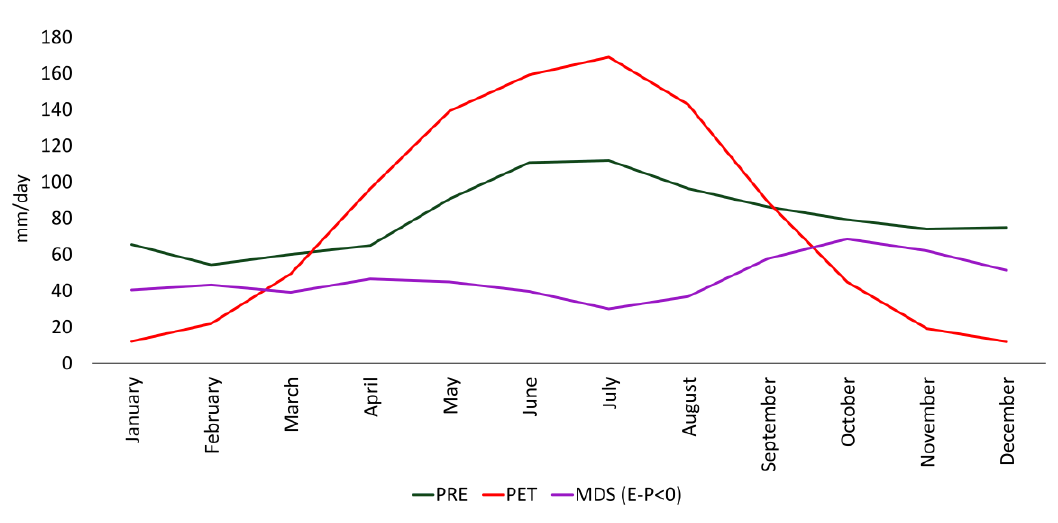
Figure 2. Climatological annual cycle of precipitation (PRE, ×10 green line), potential evapotranspiration (PET, ×10 red line) (data from the Climatic Research Unit (CRU) (TS3.24.01) (scale: mm/day) values integrated over the CEU), with the moisture contribution from the MDS (purple color (mm/day) values integrated over the CEU) to the CEU obtained via the forward experiment.